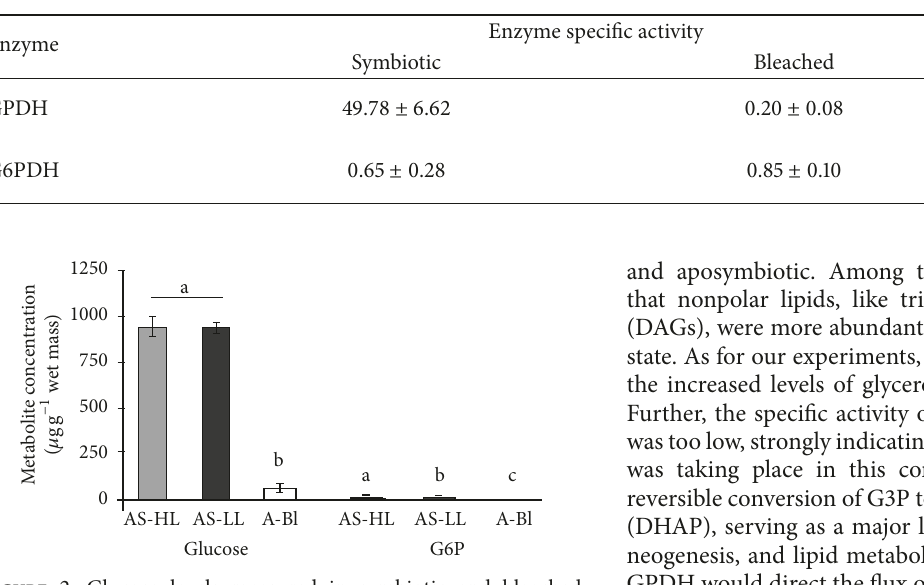
Table 2: Glycerol 3-phosphate dehydrogenase (GPDH) and glucose 6-phosphate dehydrogenase (G6PD) specific activity in anemones in the symbiotic state compared to bleached anemones. Values are the means of three independent determinations ± SD. Specific activity in units ( 𝜇 mol substrate converted min −1 ) per gram of protein mass. For each sample, three assays were performed (technical replicates) and averaged.